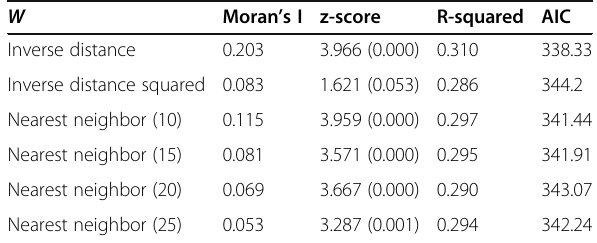
Table 2 Spatial autocorrelation of DRTP, R-squared and AIC of SAR model for different conceptualizations of spatial